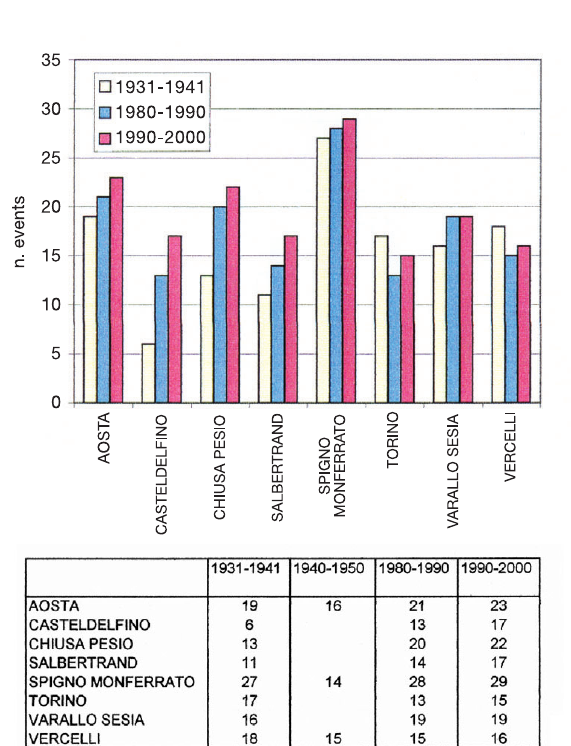
Fig. 2. Number of events of 24 h with AII different from 0.